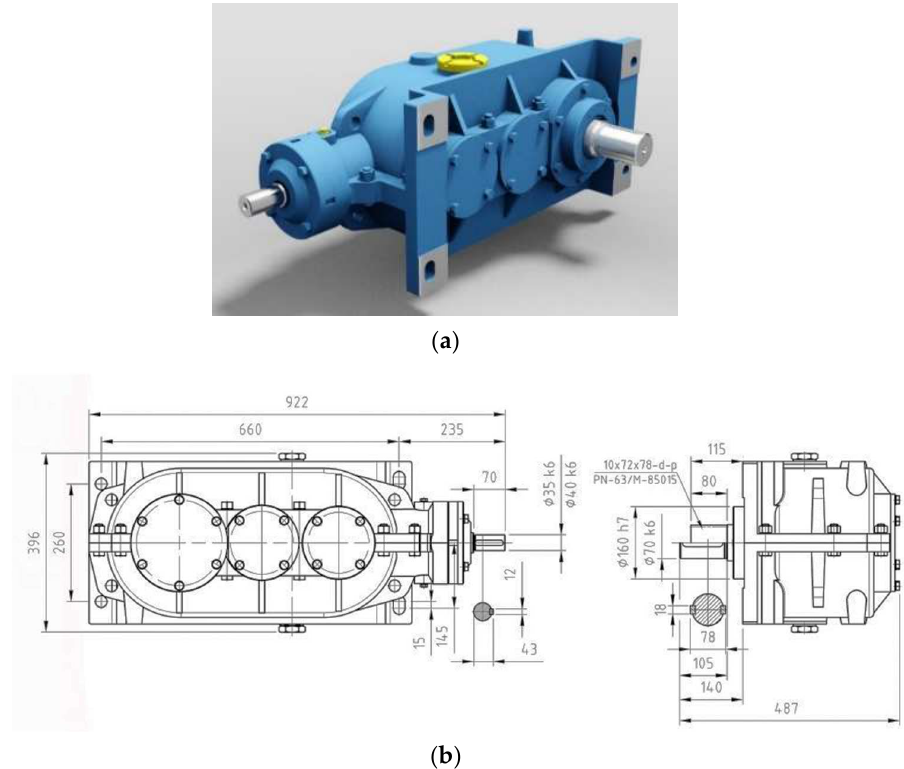
Figure 5. Type PAT-KW3 toothed gear: ( a ) schematic diagram, ( b ) connection dimensions—front and right side view